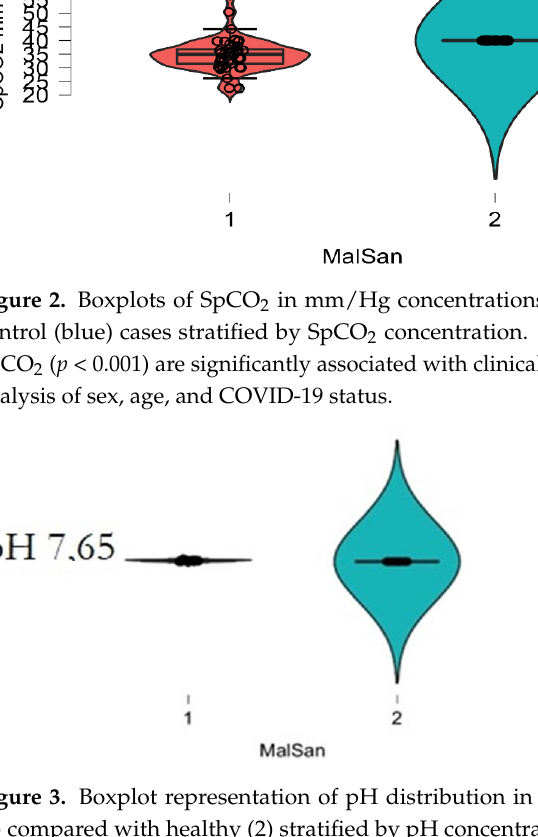
Figure 5. Box plot showing the plasma concentration of vitamin D within 48 h of hospitalization in patients with COVID-19 (red) and healthy individuals. Figure 6. Graphic showing the plasma concentration of vitamin D (blue) and IL-6 (orange-red) within 48 h of hospitalization in patients with COVID-19. 020406080100120140 160180200 1 3 5 7 9 11 13 15 17 19 21 23 25 27 29 31 33 35 37 39 41 43 45 47 49